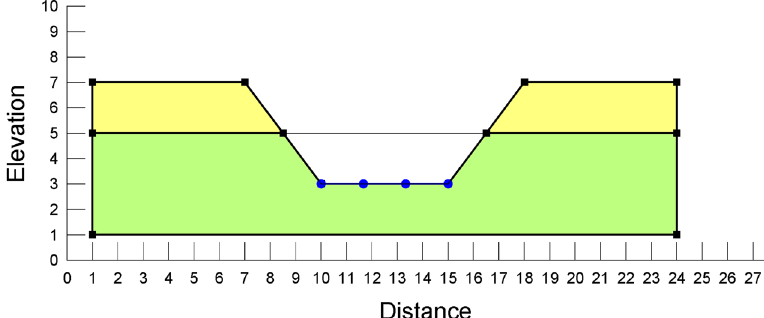
Figure 4: 2D Canal model used in SEEP/W after applying rationing